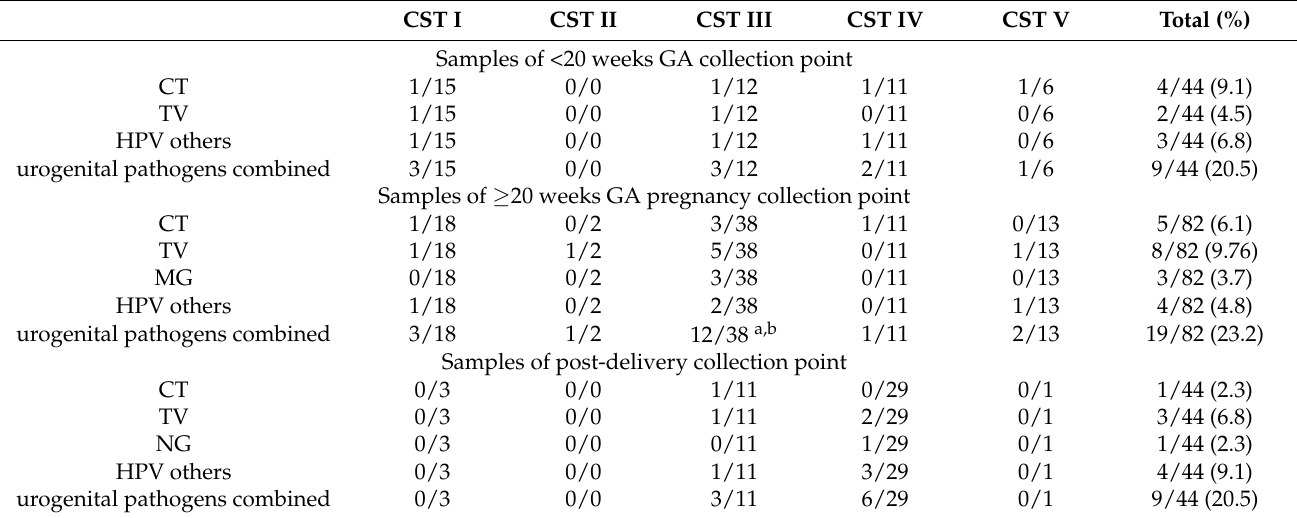
Table 4. Number of vaginal samples positive for urogenital pathogen within a community state